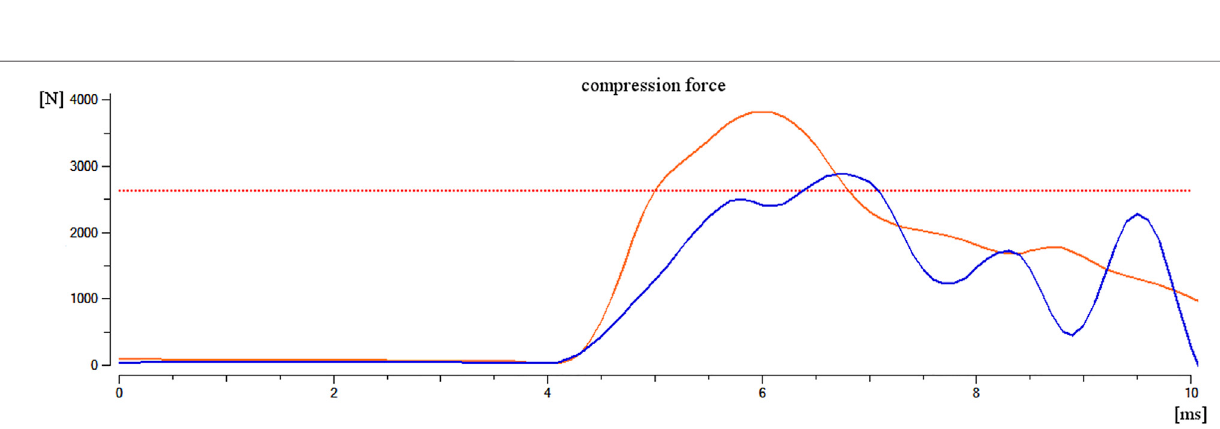
Frontiers in Bioengineering and Biotechnology |